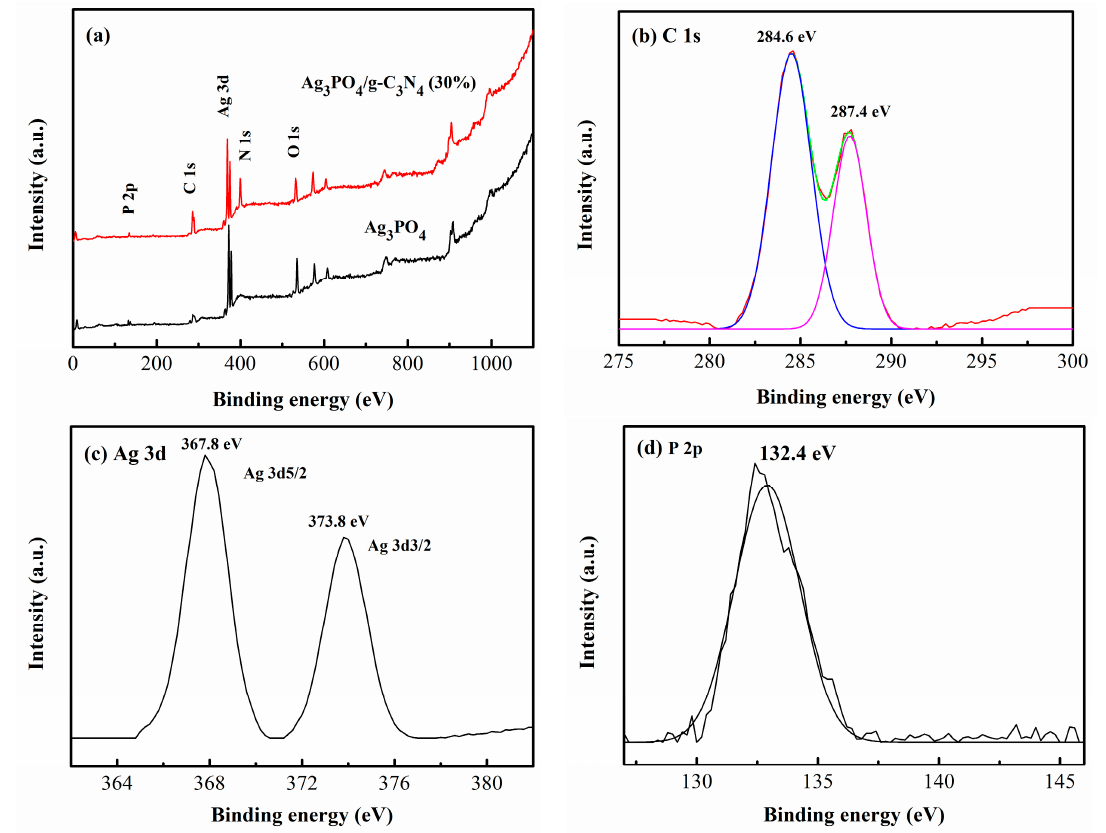
Figure 4. XPS spectrum of the Ag 3 PO 4 and Ag 3 PO 4 /g ‐ C 3 N 4 : ( a ) survey spectrum; ( b ) C 1s; ( c ) Ag 3d; and ( d ) P 2p.